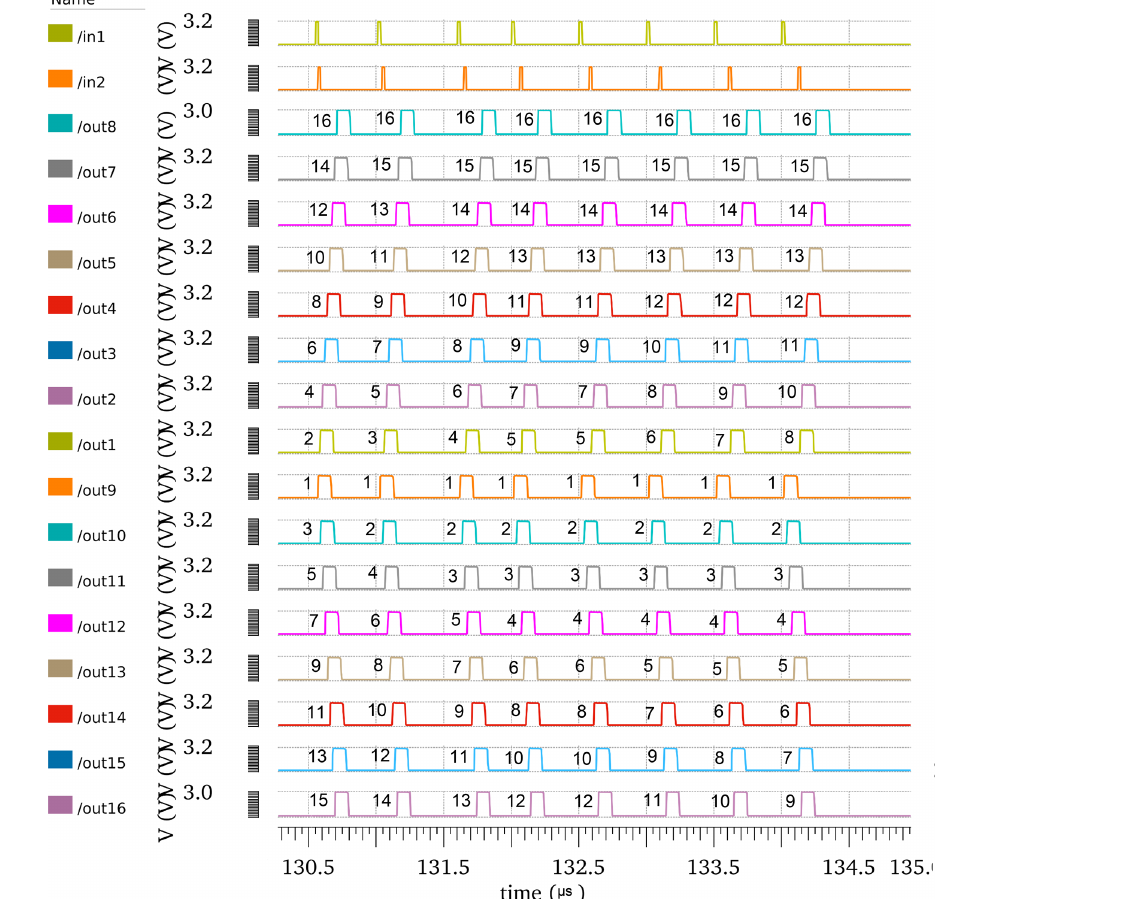
Figure 15. The simulation of ASRC rank coding, with in1 preceding in2 for corner no. 2 in Table 3 at circuit conditions, where V dd is 3.6V, temperature is − 40 ◦ C, and the process corner is the WO (worst-case one). It shows that the spike order codes vary with PVT.